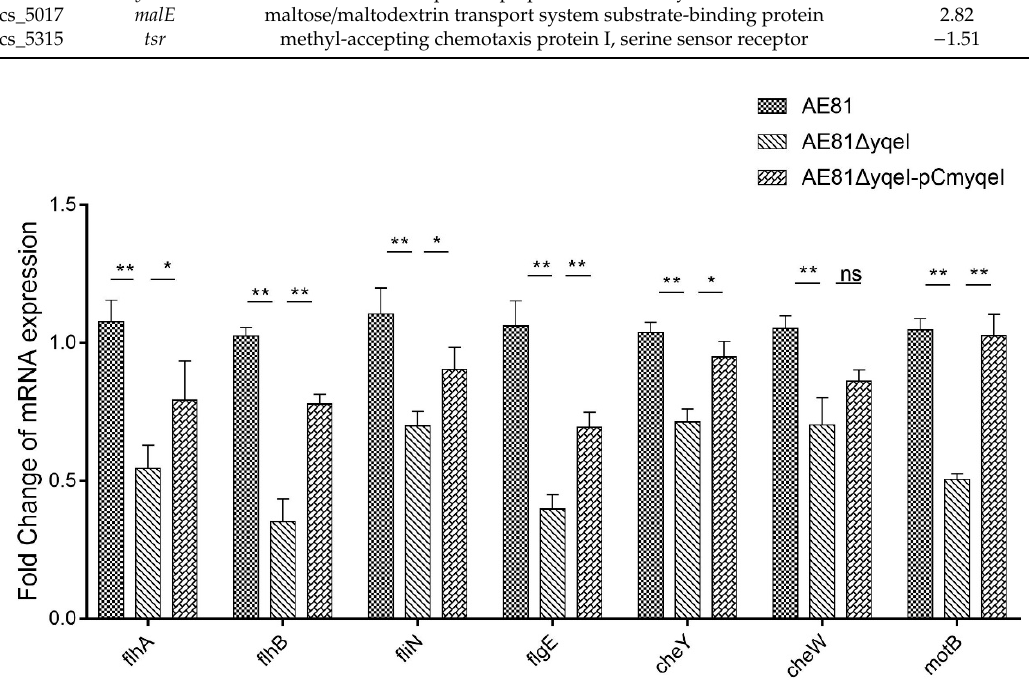
Figure 2. The relative expression of some flagella-related genes detected by qRT-PCR, * p < 0.05, ** p < 0.01, ns (no significant difference).